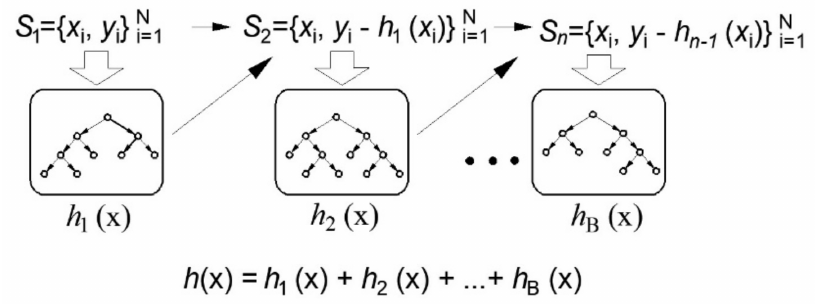
Figure 4. Gradient boosting in regression tree ensembles [34].